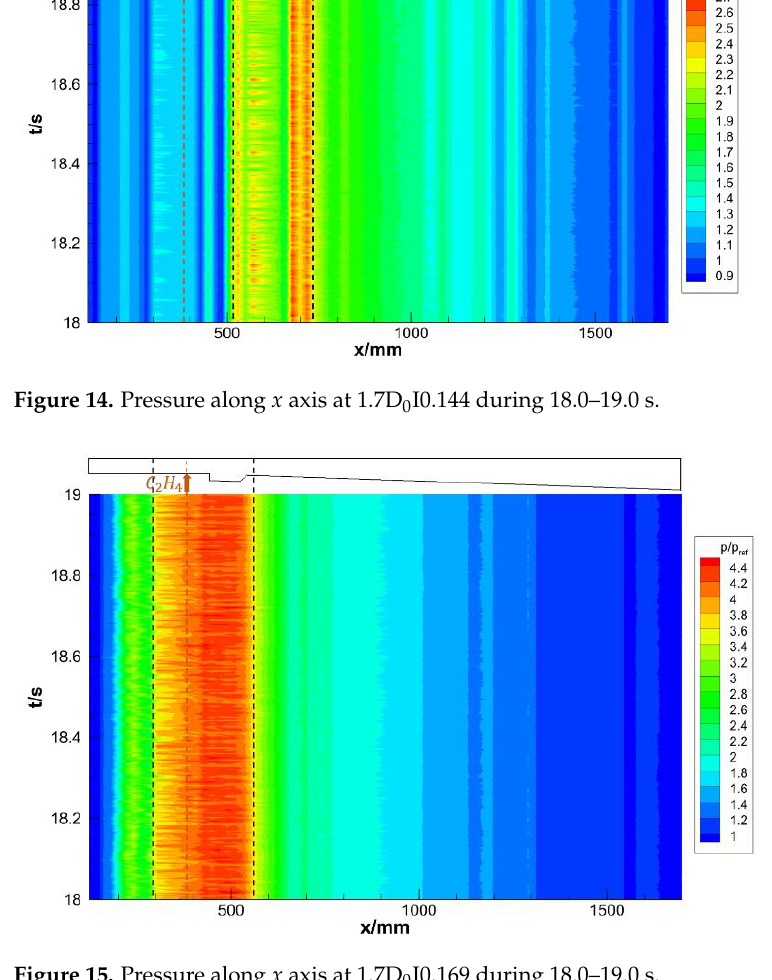
Figure 15. Pressure along x axis at 1.7D 0 I0.169 during 18.0 – 19.0 s.